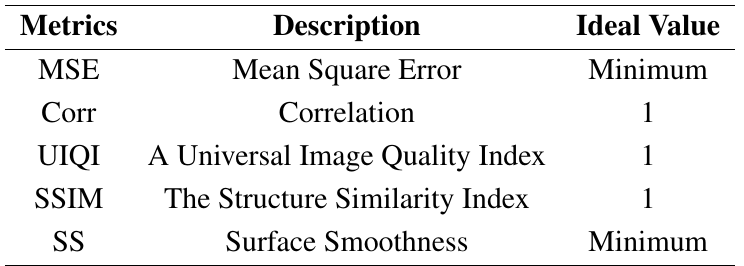
Table 1. The best value of various